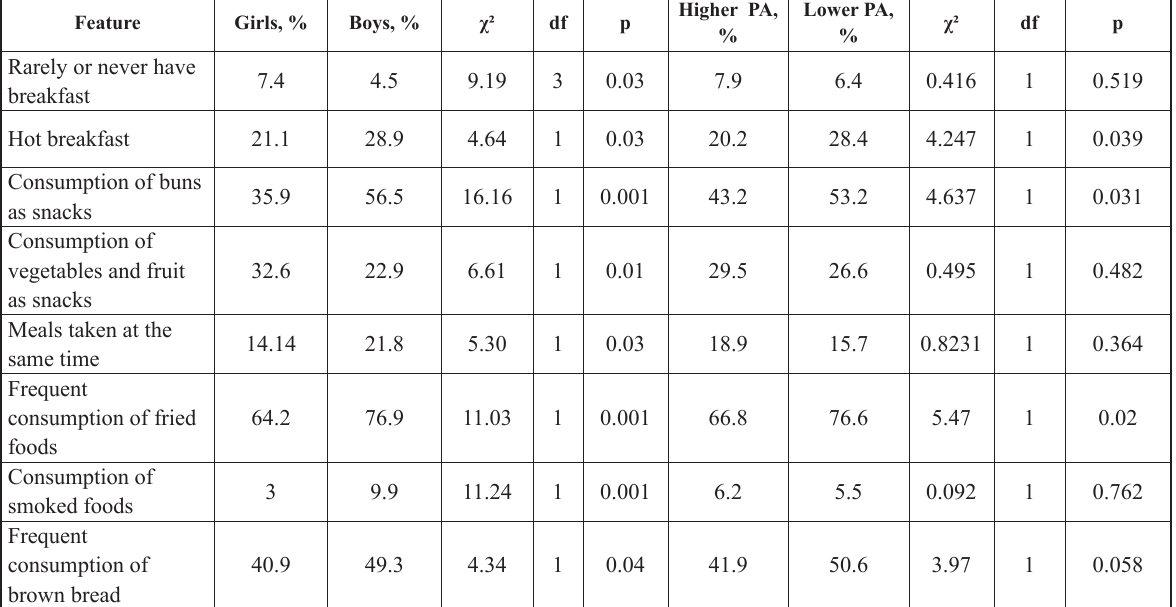
Table. Distribution of girls, boys and groups of different physical activity (PA) by nutrition